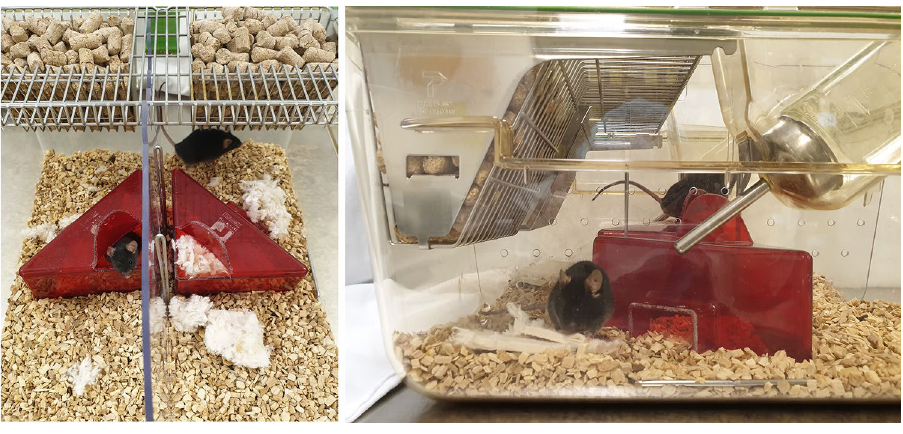
Figure 1. Pair housing system from the top and side